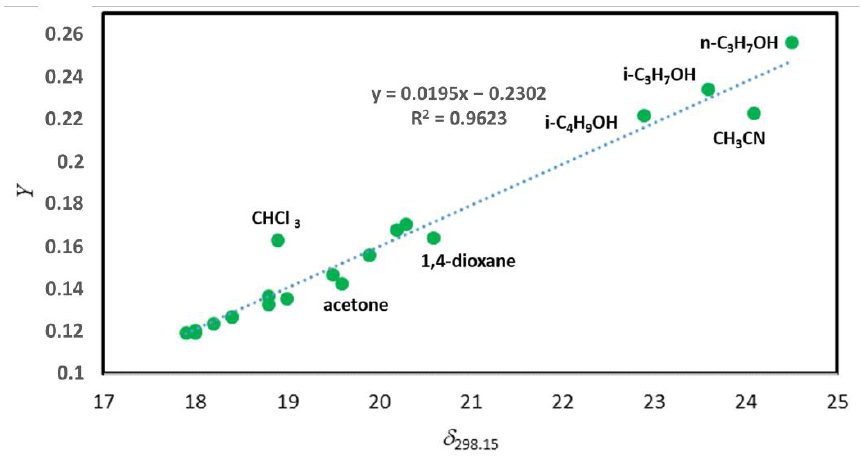
Figure 3. Regression of solubility parameters δ 298.15 of different solutes and Y- module ( Y = ( δ 1 ) 2 /( RT ) Regression of solubility parameters δ 298.15 of different solutes and Y -module −  12 / 𝑉 1∗ is the left part of Equation (5)) for [C 6 mim][CF 3 CO 2 ] derived from experimental 𝛾 1∞ values ( Y = ( δ 1 ) 2 /( RT ) − χ 12 / V ∗ is the left part of Equation (5)) for [C 6 mim][CF 3 CO 2 ] derived from ex- 1 [43]. perimental γ ∞ values 1